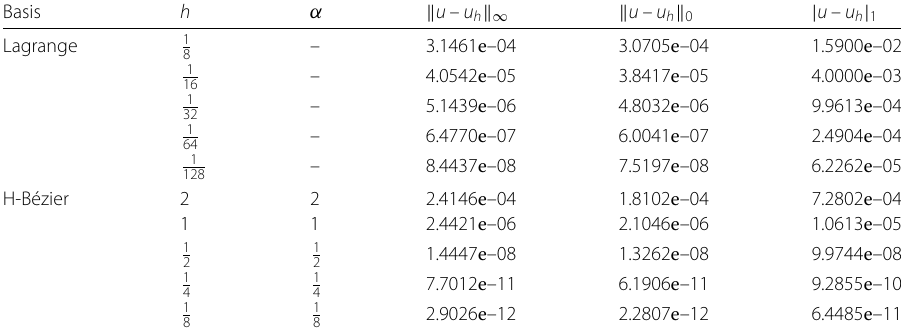
Table 5 The numerical